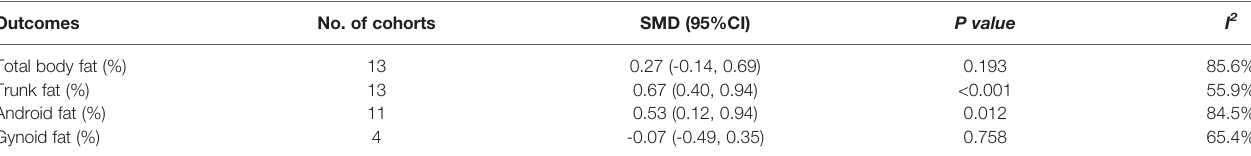
TABLE 2 | Meta-analysis results for total body fat, trunk fat, android fat, and gynoid fat in percentage (%): women with PCOS versus BMI-matched healthy controls.